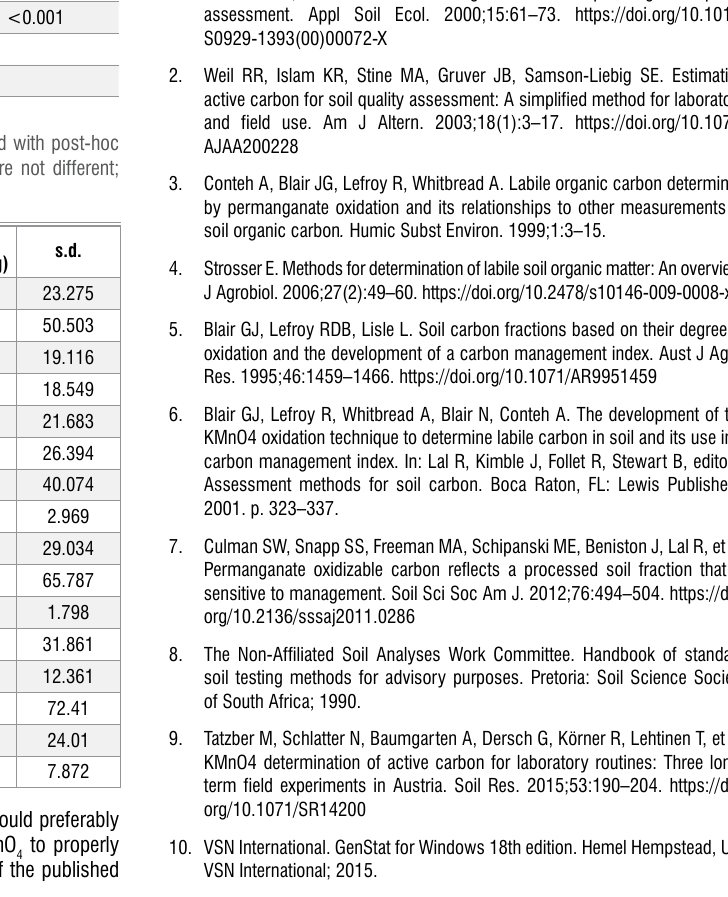
protocols suggested. In case of negative values obtained for a certain Table 2: Results of an ANOVA for active carbon in different soils extracted using different methods (amount of soil and tube soil, the experiment should be redone using 5 g of soil, because it was shaking position) found that increasing the amount of soil resulted in more detectable values in the low carbon soils, although not significantly so. Source of variation d.f. F -value p -value The final protocol that gave the best repeatable results is consistent with 2075.15 <0.001 that of Culman et al. 7 , but with the tubes lying flat while being shaken. Additionally, if negative absorbance values are obtained at 550 nm, it 7.75 0.007 is advised that the procedure should be repeated, using 5 g of soil and 512.10 <0.001 adapting the equation 86.88 <0.001 30.60